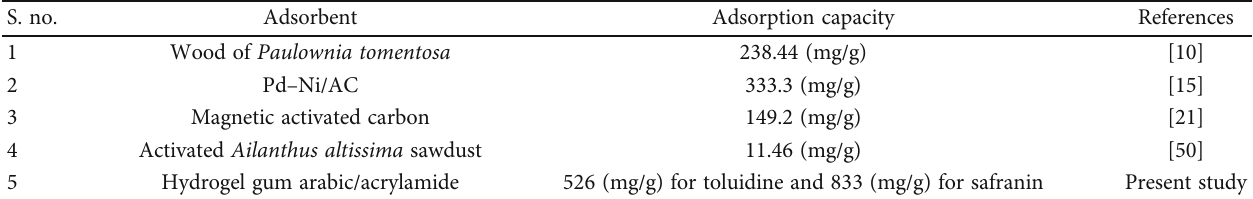
Table 6: Comparison of the hydrogel adsorption capacity with the activated carbon adsorption capacity. S.